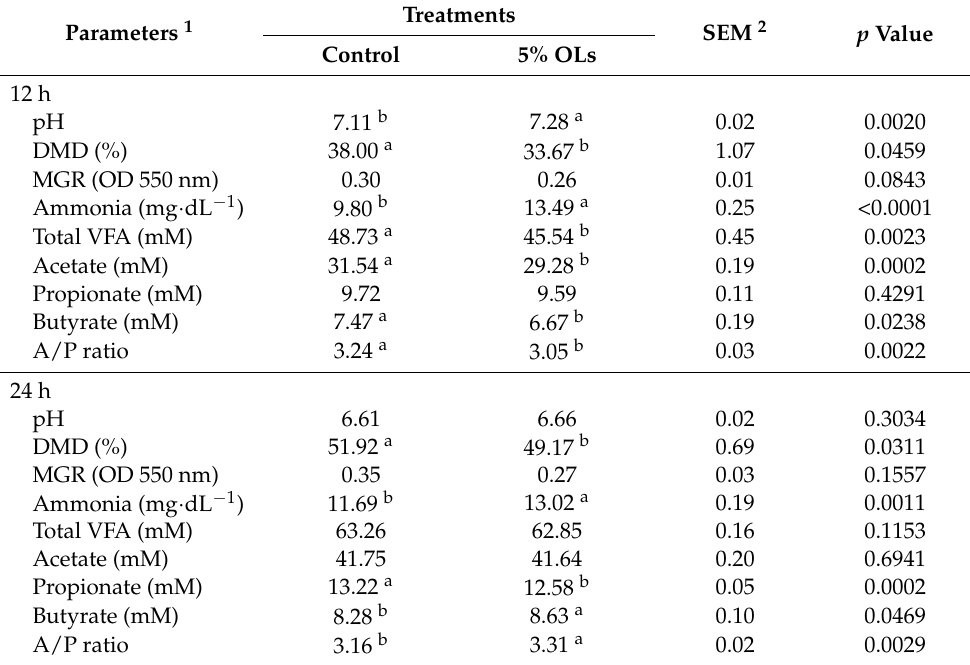
Table 5. Effects of 5% olive leaves (OLs) on in vitro gas production and fermentation characteristics at 12 and 24